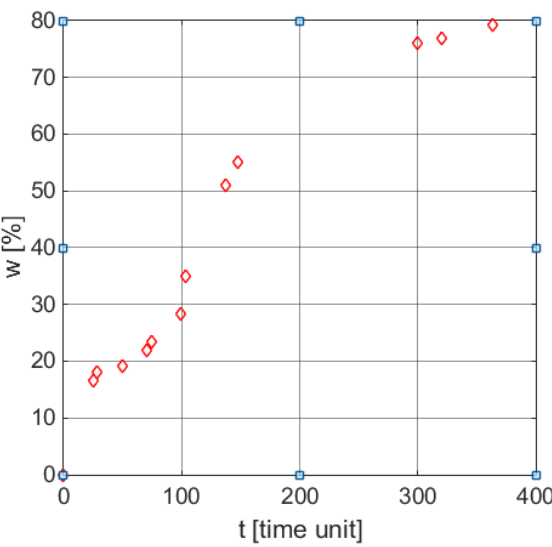
Figure 1. Weight loss profile in time for a typical biodegradation process [30].